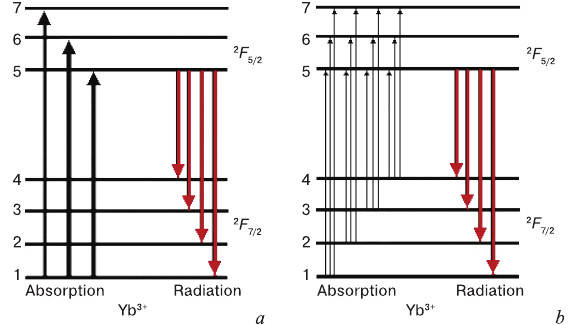
Figure 3. Structure of Stark sublevels in Yb 3+ ions: ( a ) 4.2–77 K transitions [23, 24]; ( b ) 300 K transitions.